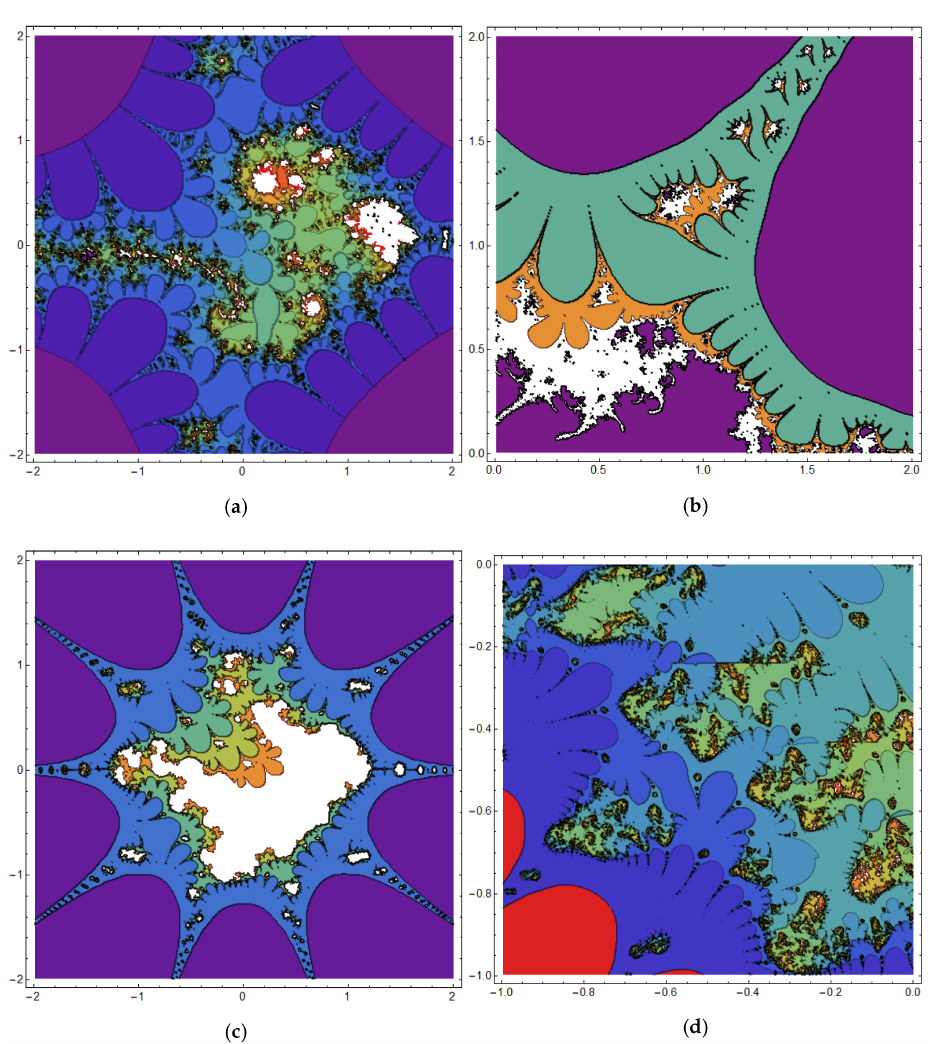
Figure 8. The Julia sets generated by the generalized fractional cosine map at α = 0.8 and